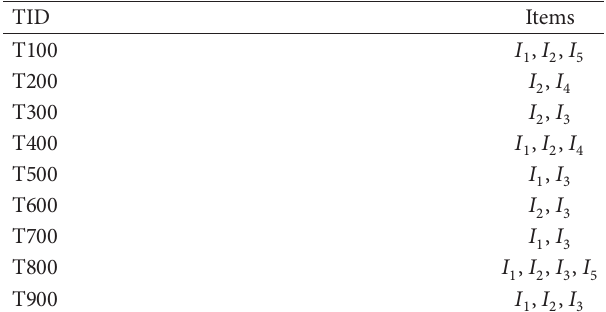
Table 2: The transactional database of the illustrative